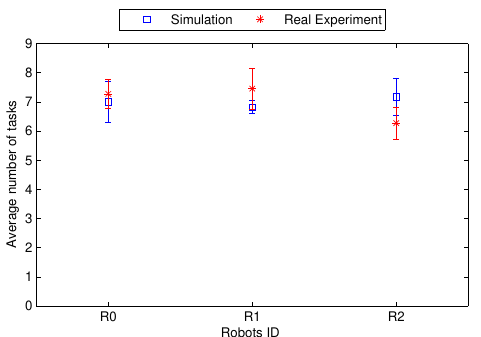
Figure 18. Average number of tasks assigned to each Turtlebot2 robot, where the total number of tasks = 21.